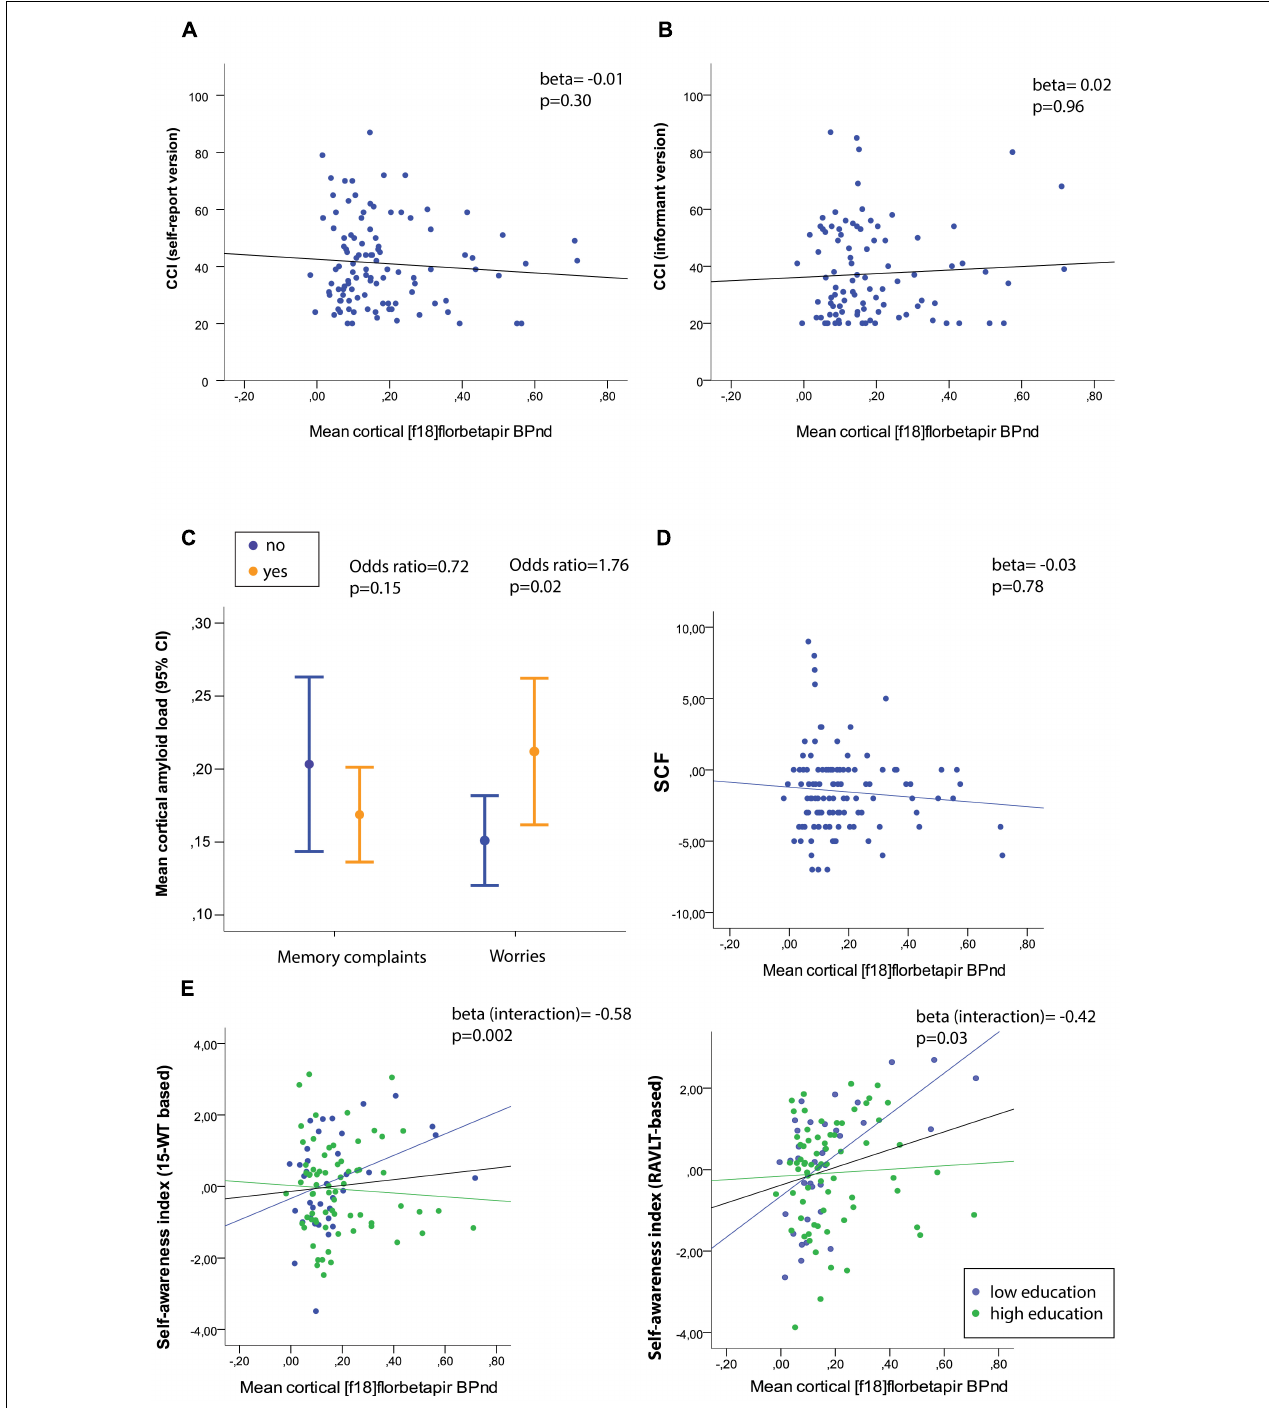
FIGURE 2 | (A) Mean cortical amyloid-beta load in relation to raw (untransformed) scores of the self-report cognitive change index (CCI) and (B) informant-based CCI, and (D) the subjective cognitive functioning (SCF) questionnaire. (C) Mean cortical amyloid-beta load stratified for memory complaints (yes/no) and worries (yes/no). (E) Associations between mean cortical amyloid load and self-awareness index based on the RBMT % delayed recall (left) and RAVLT % delayed recall (right) with stratification for low and high education level. Memory deficit awareness index: A positive index score reflects heightened self-awareness (hypernosognosia), whereas negative scores lowered self-awareness (anosognosia).